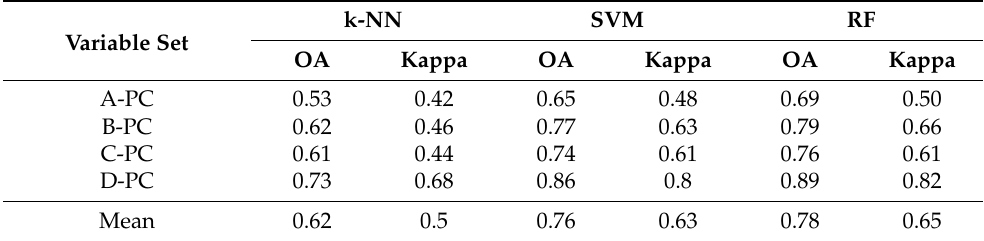
Table 3. Accuracy comparison for different classifiers with different types of variable set. Variable